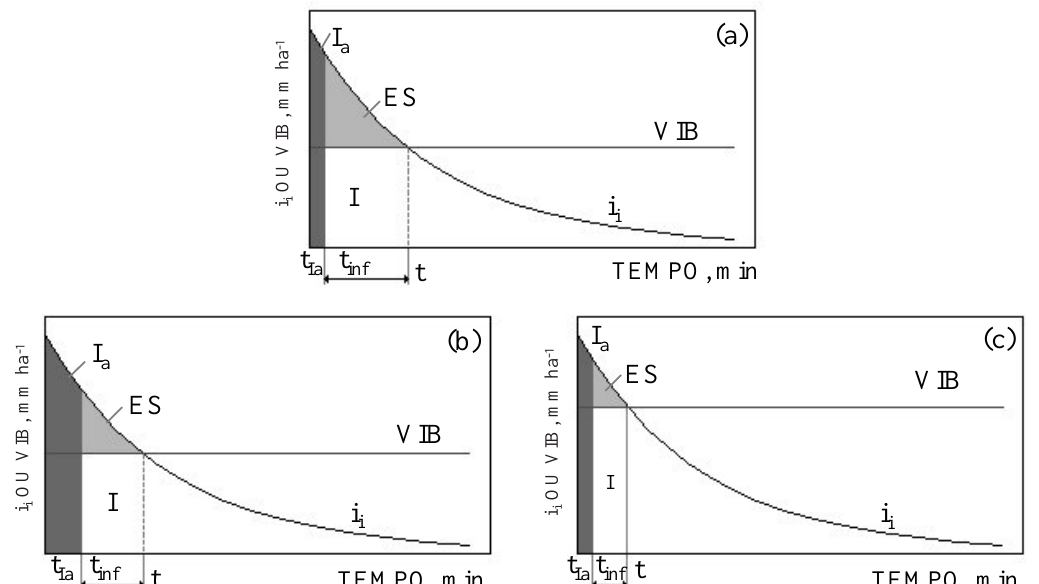
Figura 2. Componentes associados ao método proposto por Pruski et al. (1997) (a); representação da sensibilidade apresentada pelo método à variação das abstrações iniciais (b); e da velocidade de infiltração básica da água no solo (c). i = intensidade instantânea de precipitação; VIB = velocidade i = abstrações iniciais; ES = escoamento superficial; I ou taxa de infiltração básica de água no solo; I a = infiltração acumulada; t = duração das abstrações iniciais; t = duração da infiltração; t = tempo Ia inf para escoamento superficial máximo.